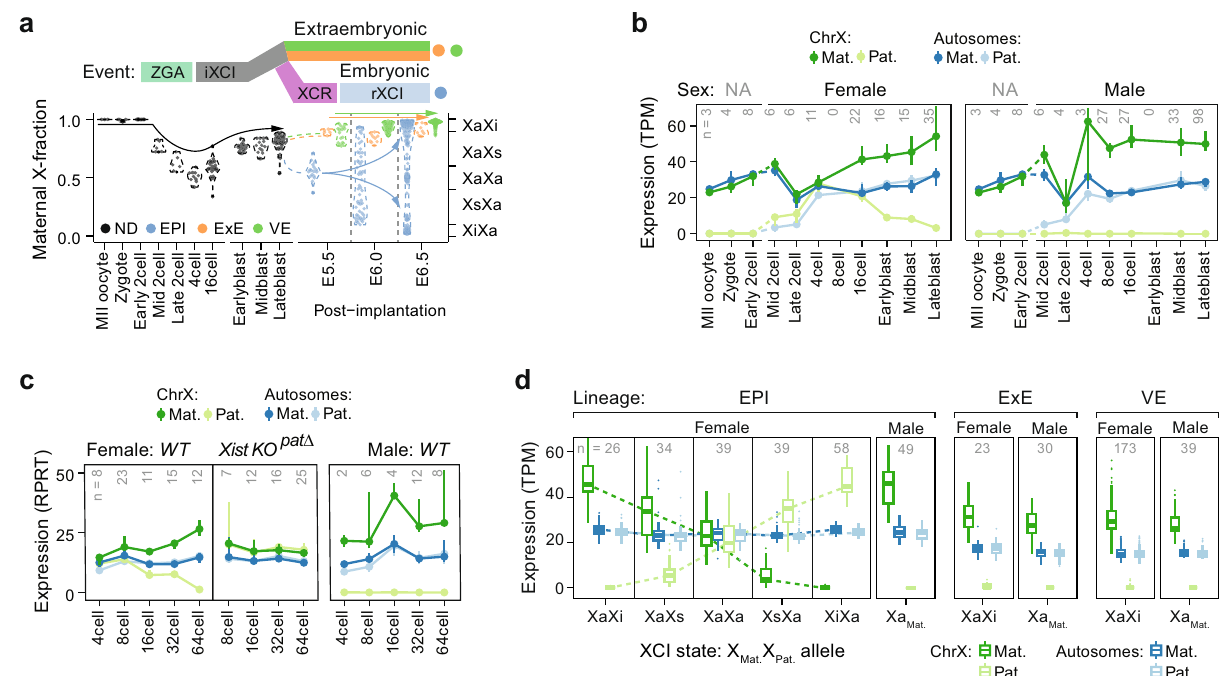
Fig. 2 Allele-level map of X-upregulation dynamics during early murine embryonic development. a Violin plots of maternal fraction X-chromosome expression in cells (dots) across the fi rst week of female mouse embryo development (x-axis), with known key events of allelic and X-chromosome regulation indicated above; ZGA (mid-2- to the 4-cell stage), iXCI (initiating at 8- to 16-cell stage), XCR (epiblast-speci fi c, late blastocyst to early implantation), and rXCI (epiblast-speci fi c following XCR). Past ZGA, the XCI states of female cells were inferred according to allelic X-chromosome expression bias (right y-axis). Cell-lineage assignment: not determine (ND), epiblast (EPI), extraembryonic ectoderm (ExE), visceral endoderm (VE). b Allele-resolved expression during preimplantation development chrX (green; n = 323 – 437 genes) and autosomes (blue; n = 11,164 – 13,347 genes) in cells of female and male embryos. Data are shown as median± 95% con fi dence interval. c Allele-resolved expression for wild-type (WT) or female Xist pat Δ knockout embryo cells along the time window of iXCI establishment for autosomes (blue; 1712 – 7908 genes) and chrX (green; 36 – 248). Legend as in panel d . RPRT reads per retro-transcribed length per million mapped reads. Data are shown as median ± 95% con fi dence interval. d Box plots of allelic gene expression levels in postimplantation cells grouped by sex and lineage. Female epiblast cells are further grouped by rXCI state where X alleles are assigned as active (Xa), inactive (Xi), or semi-inactive (Xs) i.e., ongoing XCI establishment. Shown for chrX (green; n = 597 – 713) and autosomes (blue; n = 14,941 – 17,643 genes). Data are shown as median, fi rst, and third quartiles, and 1.5x IQR. b – d Number of individual cells per condition shown within